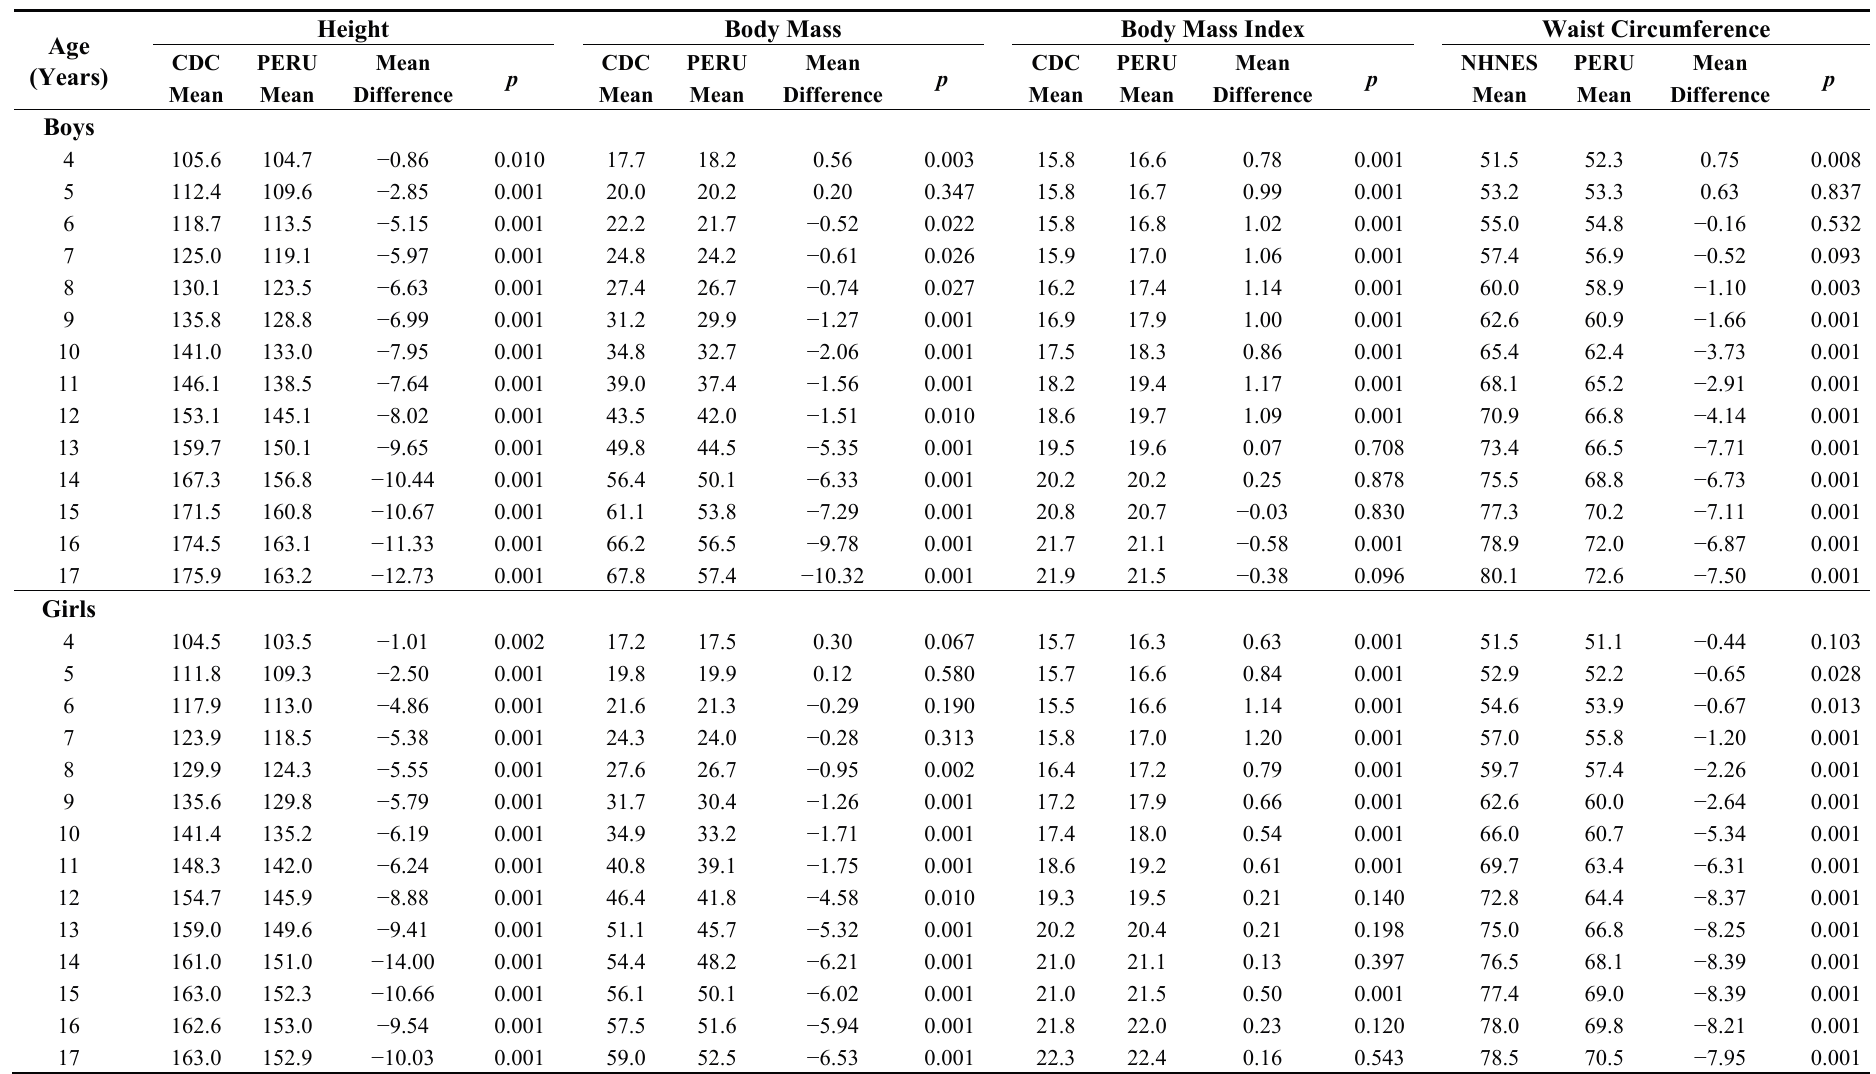
Table 6. Results of mean differences between the CDC and Peruvian schoolchildren for height, body mass, body mass index and waist circumference from both sexes aged 4 to 17